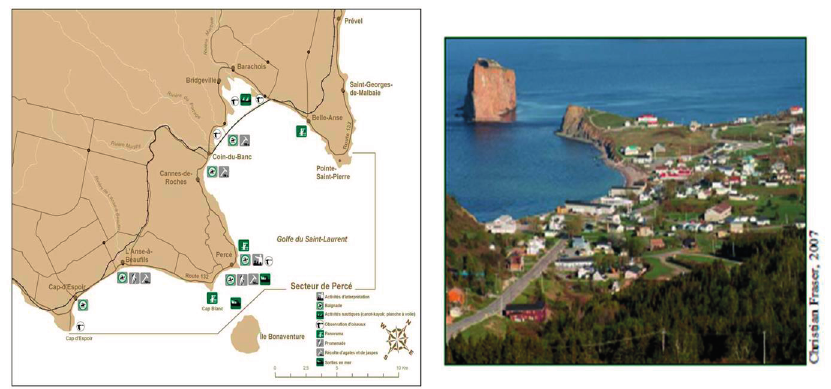
Figure 8. Geographical view of Perce, Eastern Quebec,